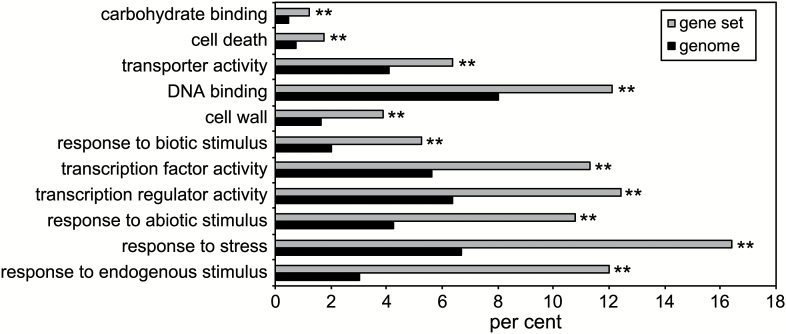
GO enrichment analysis of significantly down-regulated (P-value <0.05) genes in 2-week-old seedlings 2 h after treatment with 100 nM IDL7-EPIP peptide. Control seedlings were treated with 100 nM MOCKIDL7 peptide. The 10 terms most significantly enriched in the gene set are listed from top to bottom. Bars show the frequency of each GO term in the IDL7-responsive gene set and the genome. **P-value <0.01.